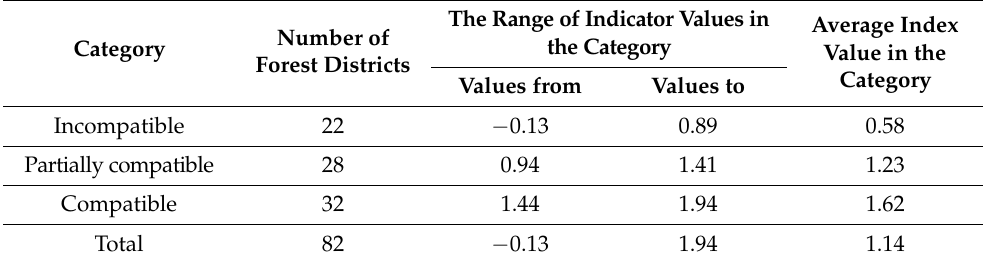
Table A3. Categories of forest districts distinguished on the basis of compatibility between stand species composition and forest site type.